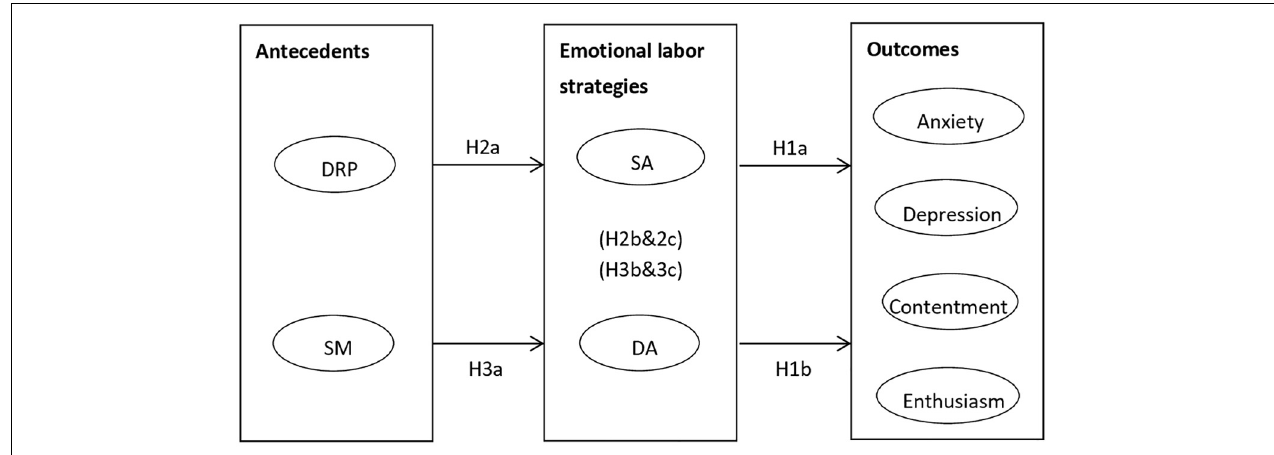
FIGURE 1 | The hypothesized model. DRP, Display rule perceptions; SM, Self-monitoring; SA, surface acting; DA, deep acting; H2b&3b and H2c&3c denote the mediating roles of emotional labor strategies as well as the indirect effects of antecedents on outcomes respectively.